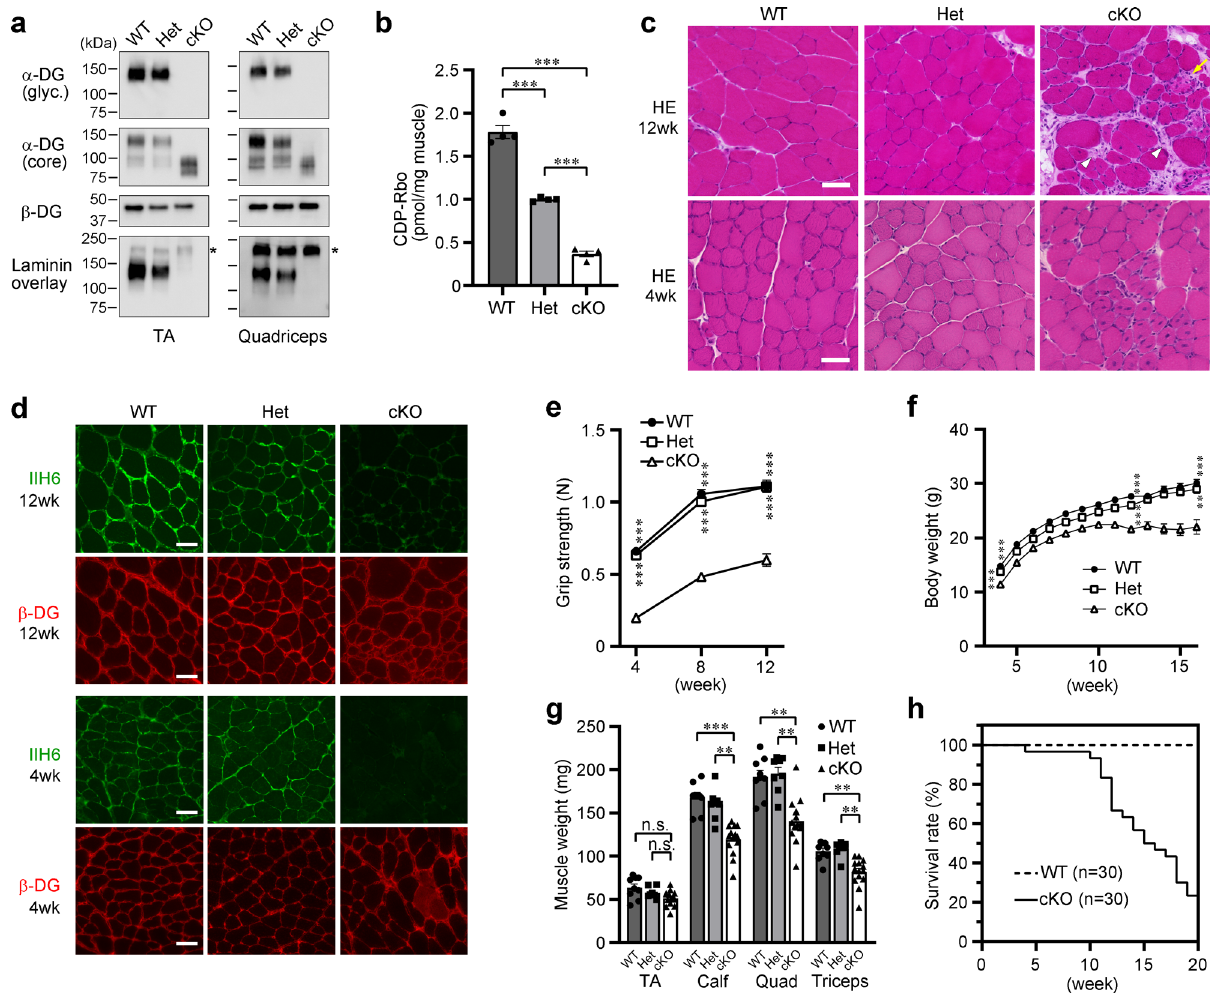
Fig. 1 Biochemical and pathological characterization of skeletal muscle from Myf5- Ispd -cKO mice. a Glycosylation and laminin-binding activity of α -DG from the skeletal muscle of WT, Het, and cKO mice (12-weeks-old) analyzed using western blotting and laminin overlay assays with antibodies against matriglycan (glyc., IIH6) and core protein (3D7). β -DG was used as a loading control. *, endogenous laminin. b Endogenous CDP-Rbo concentration in skeletal muscle tissue extracts (TA) detected using LC-MS. Data were analyzed using ANOVA with Tukey ’ s post hoc test ( p < 0.0001 for each comparison. n = 4). c , d Representative HE staining images ( c ) and DG immuno fl uorescence analysis ( d ) in the skeletal muscle (TA) of 4- and 12-week-old mice. Arrow, necrotic fi ber; arrow head, fi brous connective tissue. e , f Temporal changes in the grip strength ( e ) and body weight ( f ) of cKO, Het, and WT mice. ( e : p < 0.0001 for each cKO vs. WT and cKO vs. Het comparison. WT, n = 46, 41, and 25; Het, n = 41, 40, and 31; a n d cKO, n = 54, 53, and 30 at 4, 8, and 12 weeks, respectively. f : p < 0.0001, p < 0.0001, and p = 0.0001 for cKO vs. WT; p = 0.0004, p < 0.0001, and p = 0.0018 for cKO vs. Het at 4, 12, and 16 weeks, respectively. WT, n = 50, 30, and 17; Het, n = 45, 33, and 19; and cKO, n = 62, 39, and 12 at 4, 12, and 16 weeks, respectively). g Muscle weight in 12-week-old mice (Calf: p < 0.0001, cKO vs. WT; p = 0.005, cKO vs. Het. Quad: p = 0.0031, cKO vs. WT; p = 0.001, cKO vs. Het. Triceps: p = 0.0028, cKO vs. WT; p = 0.0012, cKO vs. Het. WT, n = 9; Het, n = 8; cKO, n = 14). h Survival of Myf5- Ispd -cKO mice ( n = 30). All data represent the mean ± SEM. Data were analyzed usi n g the Kruskal-Wallis ANOVA test followed by Dunn ’ s multiple comparison ( e – h ). ** p < 0.01, *** p < 0.001. Scale bars, 50 μ m. TA, tibialis anterior. Quad,